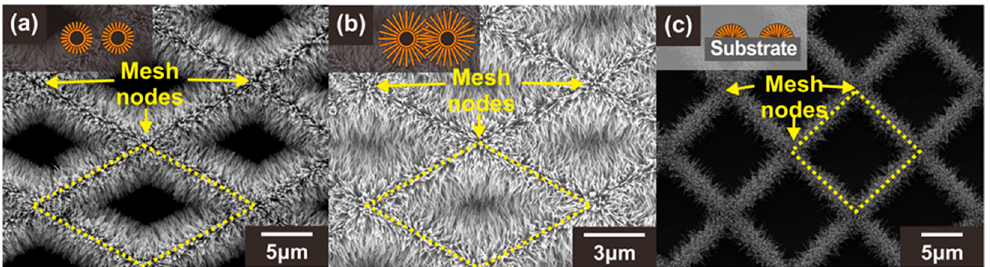
Figure 3. SEM images of three different types of ZnO NW junction networks: ( a ) Type A: ZnO NWs grown on the suspended carbon mesh with large voids, ( b ) Type B: ZnO NWs grown on the suspended carbon mesh with small voids leading to the formation of additional NW junctions, ( c ) Type C: ZnO NWs grown on the substrate. The insets show schematic illustrations of the cross section of each structure (orange: ZnO NWs, black: carbon mesh). Yellow dotted diamonds indicate the void region of the carbon mesh.